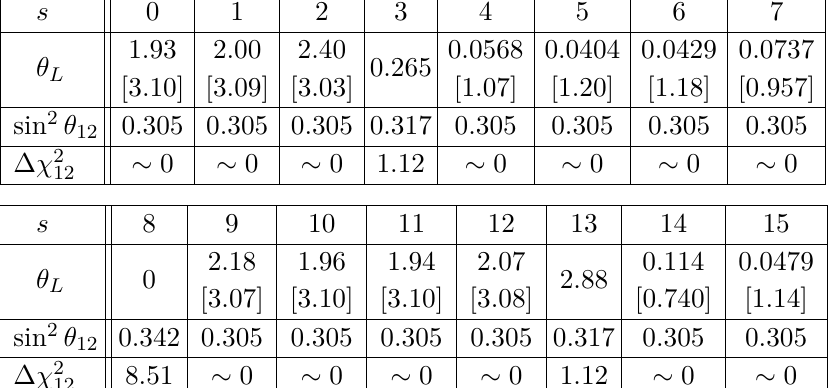
0 . 387 23 ≈ , ∆ χ 2 , for light neutrino 12 12